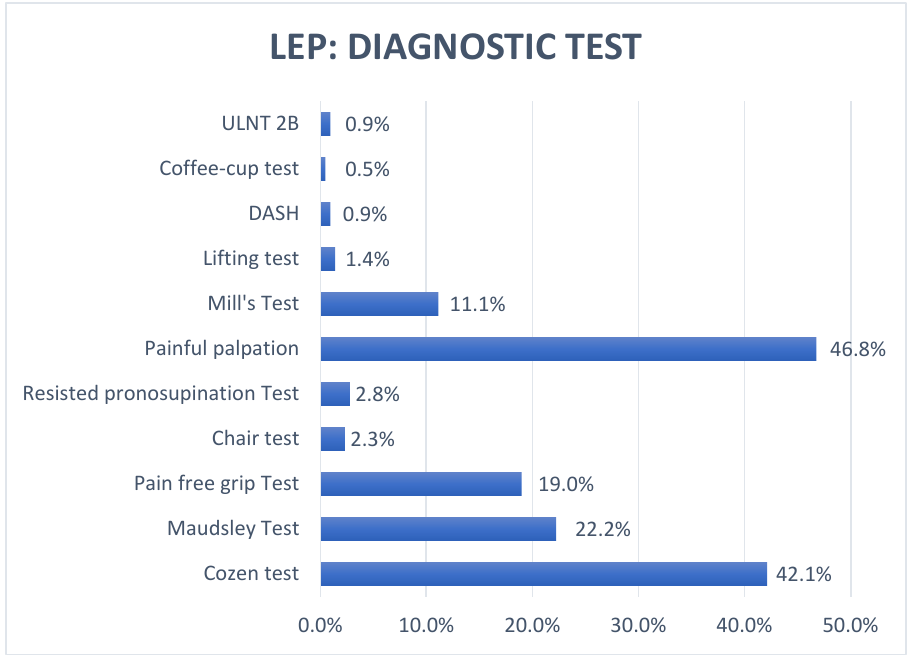
Figure 3. Diagnostic test in lateral elbow pain (LEP); legend: ULNT—upper limp neural test; DASH—Disabilities of the Arm, Shoulder, and Hand; LEP—lateral elbow pain.